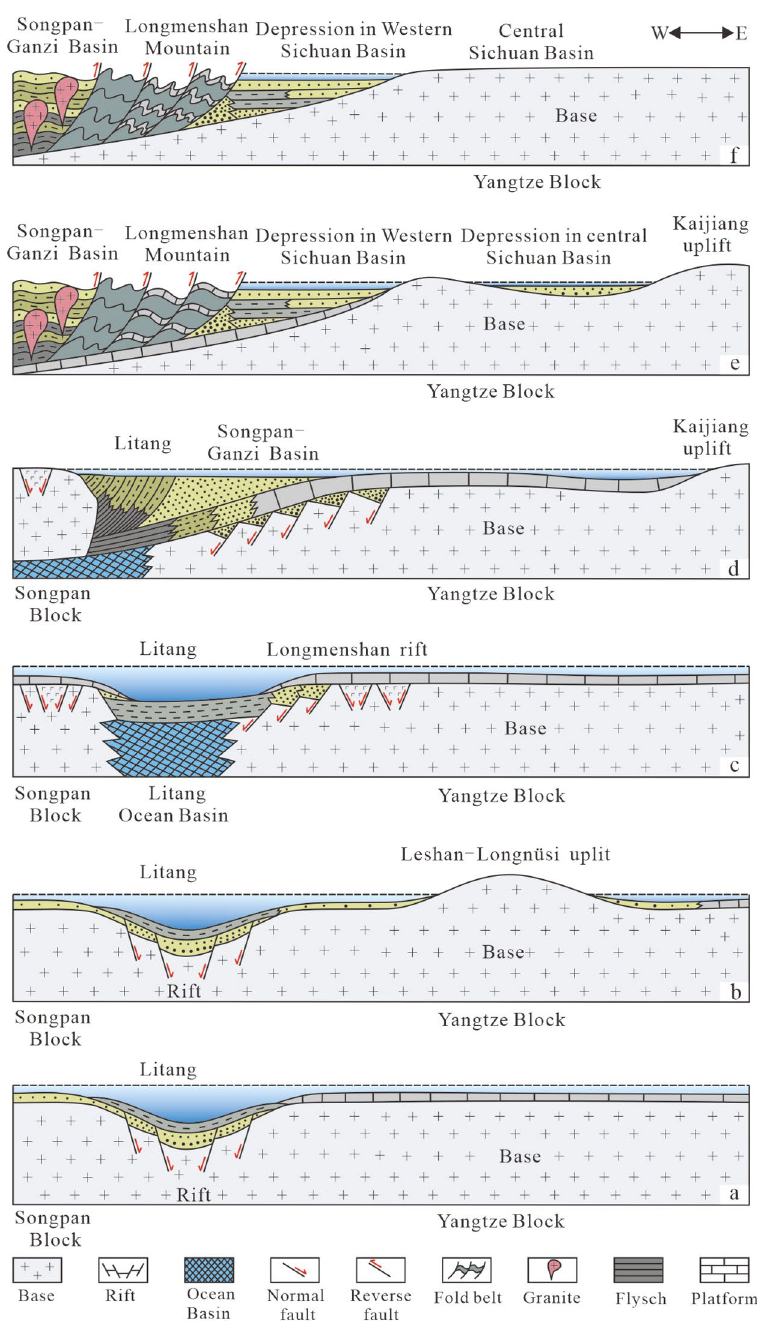
Figure 1. Tectonic evolution diagram of the western margin of the Yangtze Block (modified from He 21 and Liu 22 . ( a ) The Sinian to the Middle Ordovician (635–458.4 Ma); ( b ) the Late Ordovician to the Silurian (458.4– 416 Ma); ( c ) The Devonian to the Middle Permian (416–259.8 Ma); ( d ) The Late Permian to the Middle Triassic (259.8–237 Ma); ( e ) The Late Triassic (237–201.3 Ma); ( f ) The Jurassic to the Quaternary (201.3–0